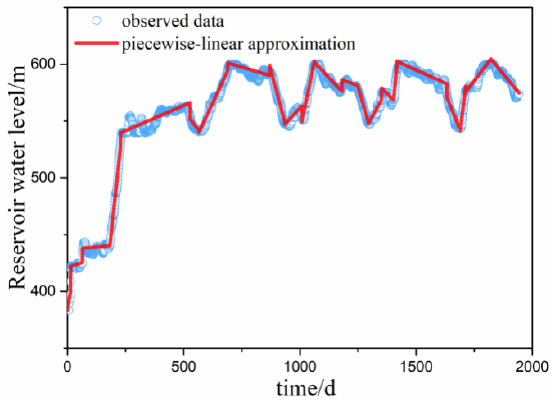
Figure 5. Reservoir water level duration curve represented with piecewise-linear approximation.